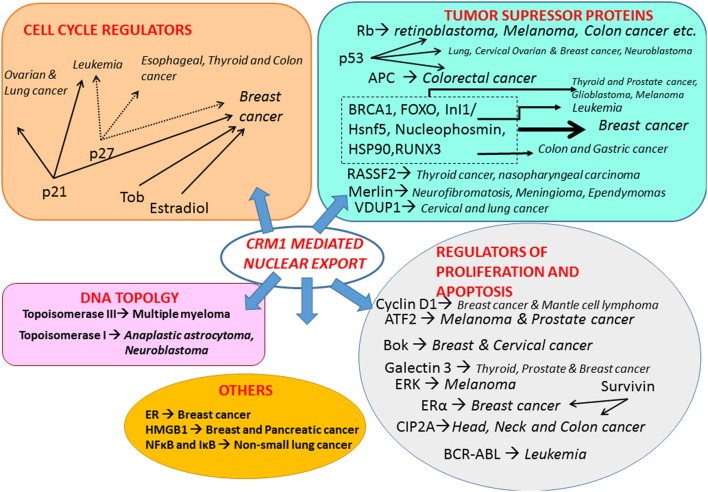
Function of CRM1-mediated export and its significance in cancer. The illustration summarizes some of the key proteins, including tumor suppressor proteins, cell cycle regulators, mediators of cell proliferation and apoptosis, proteins involved in maintenance of chromosomal and nuclear structures and others, regulated by CRM1-mediated nuclear export and their role in several solid and/or hematological malignancies. Abbreviations. APC, Adenomatous Polyposis Coli; ATF2, Activating transcription factor 2; BCR-ABL, Breakpoint Cluster Region/Abelson murine leukemia viral oncogene homolog 1 Bok, Bcl-2 related ovarian killer; BRCA1-Early Onset Breast Cancer 1; CIP2A, Cancerous Inhibitor of PP2A; ERα, Estrogen Receptor; ERK, Extracellular signal-Regulated Kinases; FOXO, Forkhead family of transcription factors; HMGB1, High Mobility Group Box 1; Hsp90, Heat Shock Protein 90; RASSF2, Ras association (RalGDS/AF-6) domain family member 2; RB, Retinoblastoma; RUNX3, Runt-related transcription factor 3; Tob, Transducer of ErbB-2.